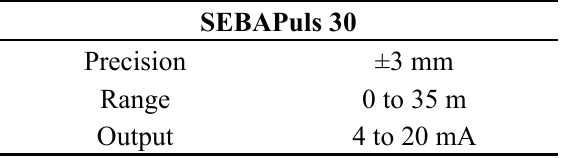
Table 10. Specifications of the SEBAPuls 30